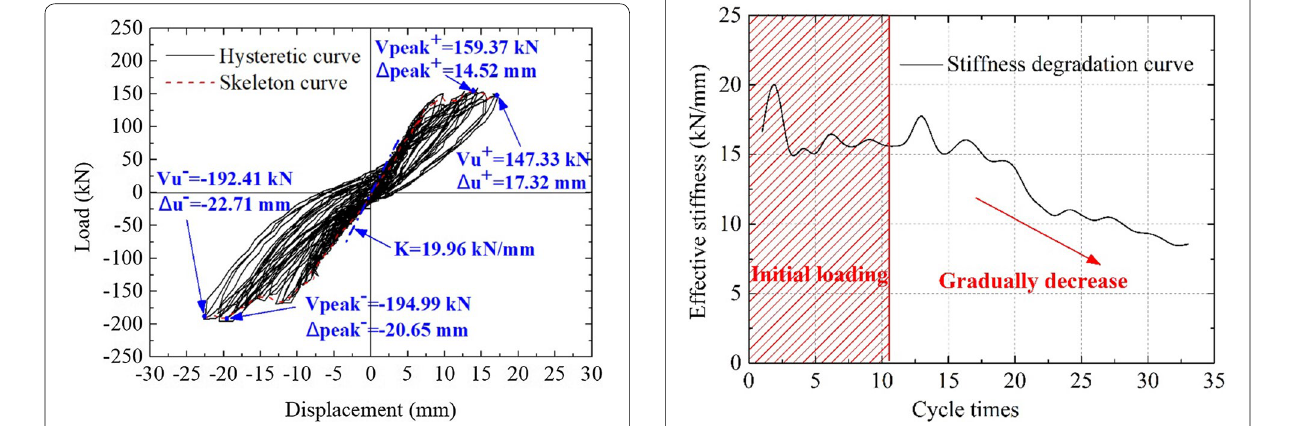
Fig. 8 Hysteretic curve and skeleton curve